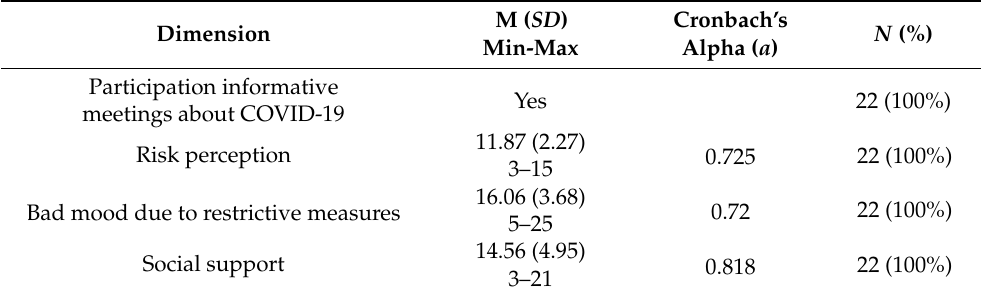
Table 2. Descriptive statistic of COVID information and risk perception, bad mood, and social support during the